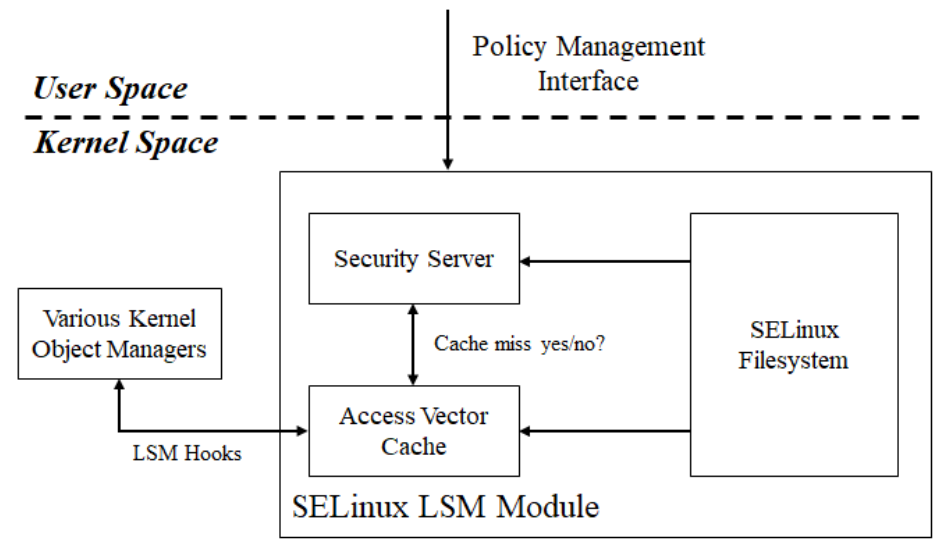
Figure 2. File access control structure of SELinux. SELinux registers the access control policy at the security server in the kernel and enforces it using the access vector cache.